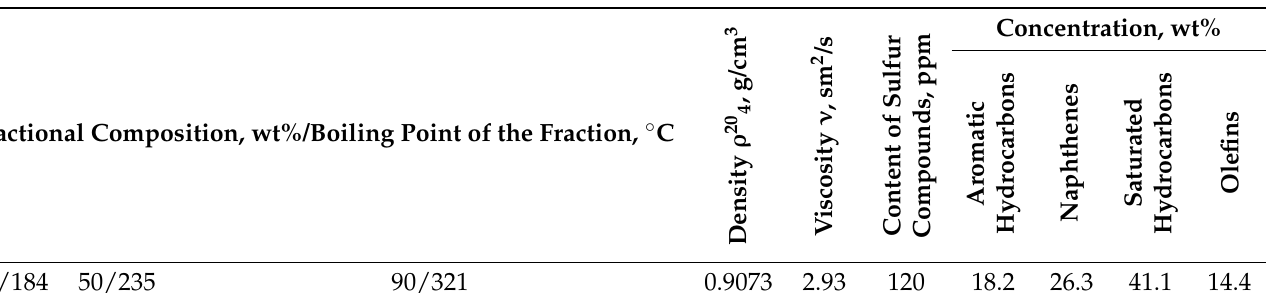
Table 4. Properties of the investigated diesel